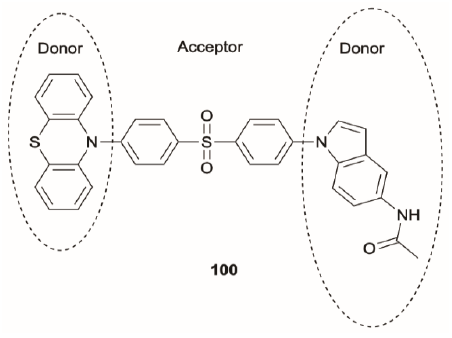
Scheme 33. Chemical structure of compound 100